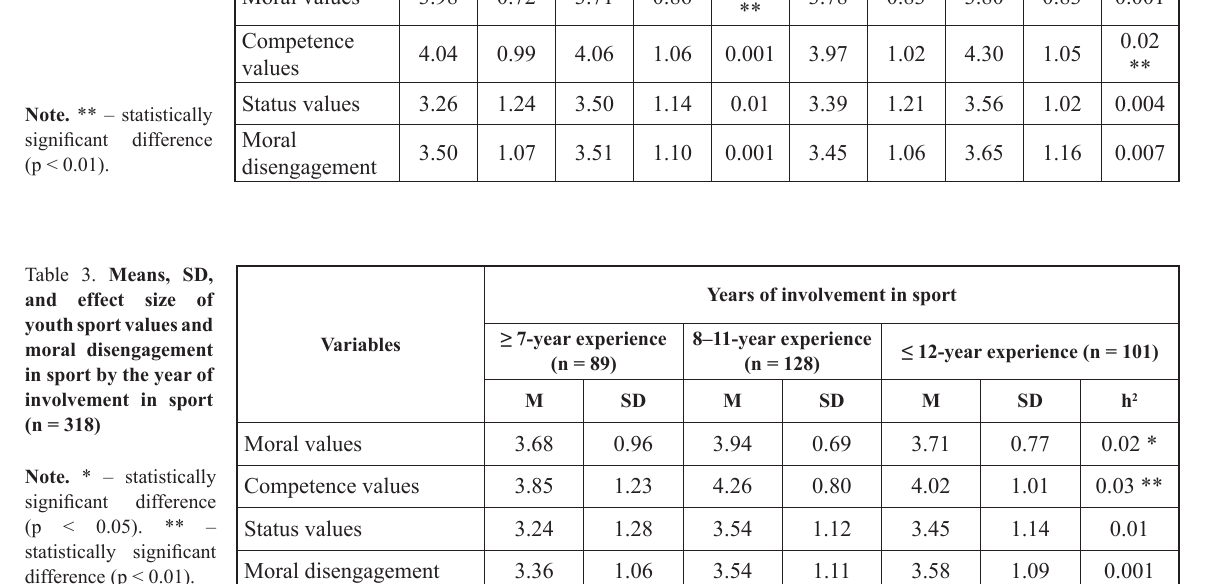
Table 2. Means, SD, and effect size of youth sport values and moral disengagement in sport by athletes’ gender and mastership (n = 318)